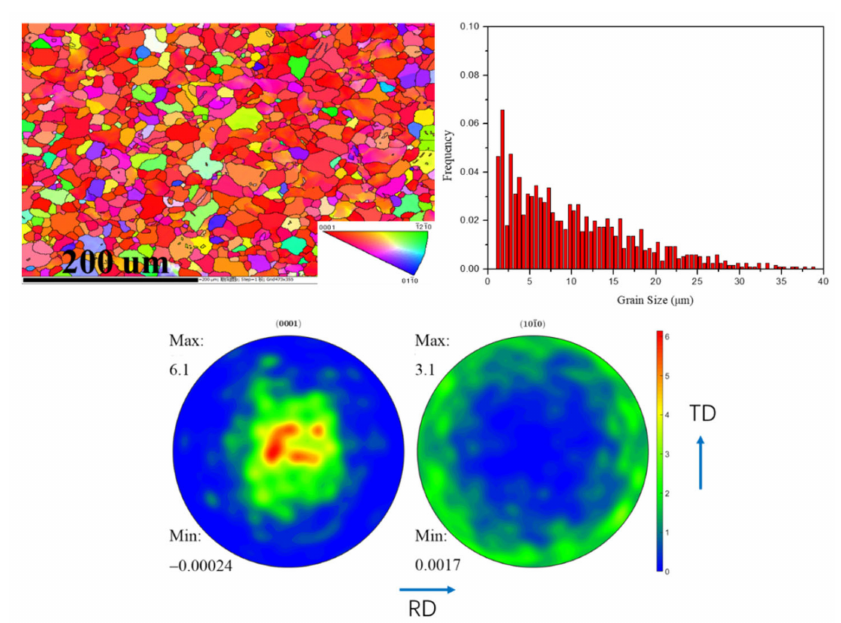
Figure 1. Initial microstructure of as-received Mg-1.9Mn-0.3Ce alloy sheet measured by